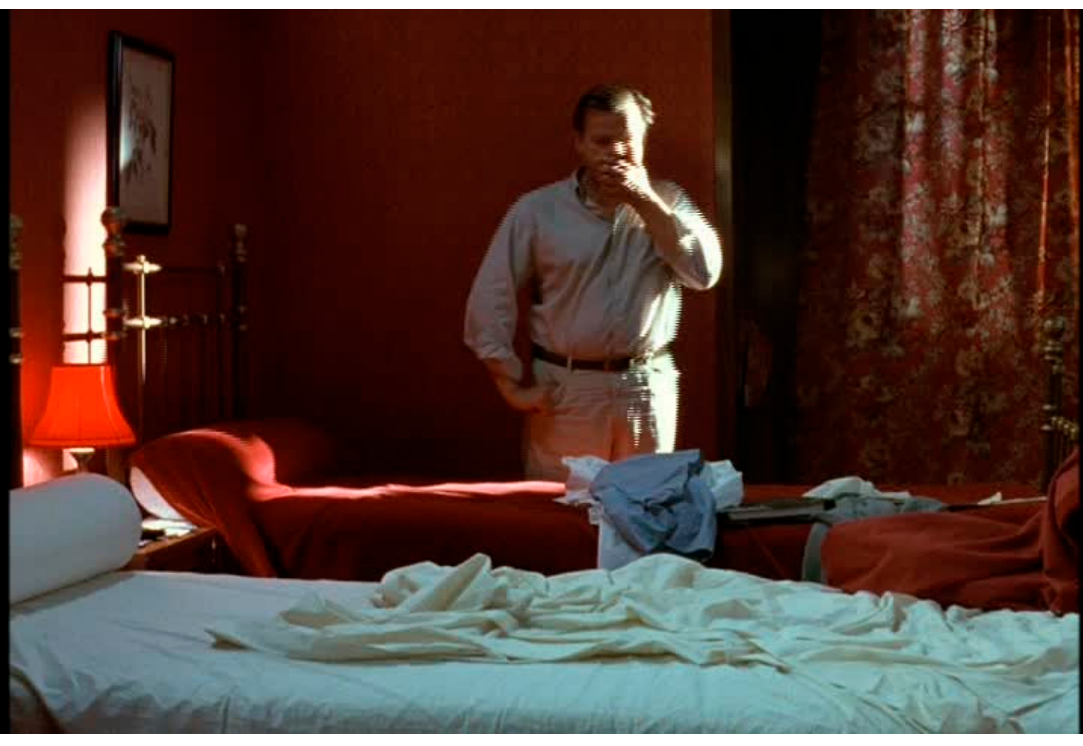
Figure 6. David retreats...